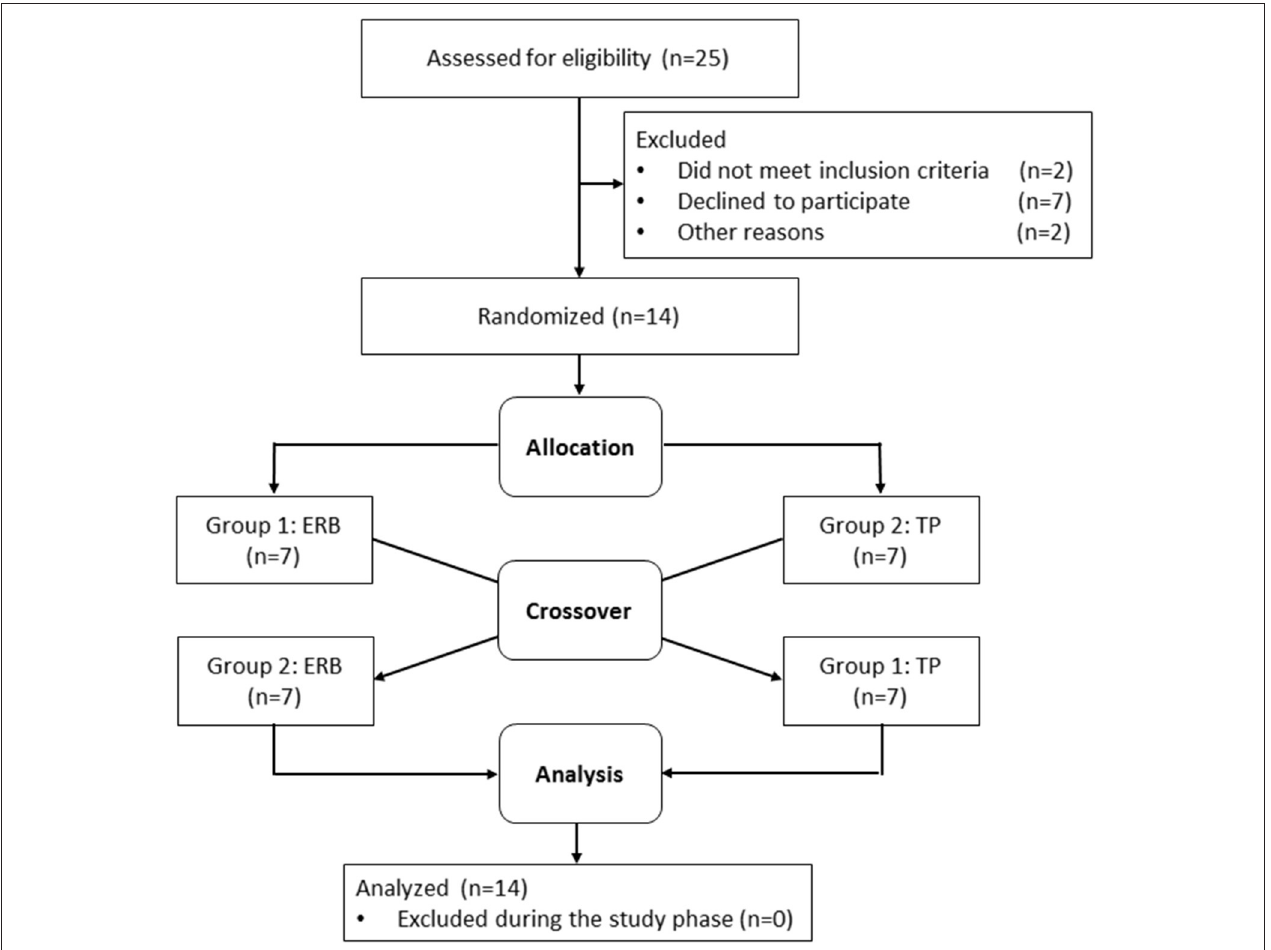
FIGURE 1 | Participant flow chart and randomization. ERB, expiratory resistance breathing; TP, tachypnea.